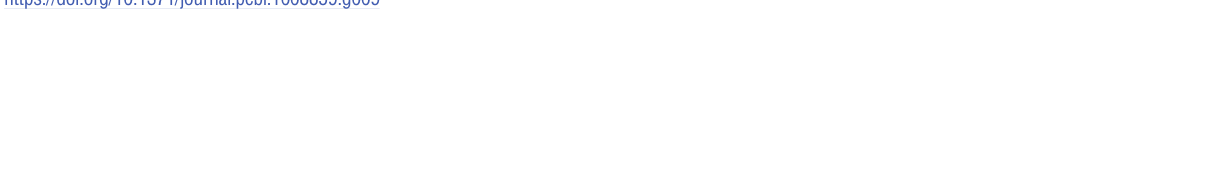
PLOS Computational Biology | https://doi.org/10.1371/journal.pcbi.1008859 May 13, 2021 13 /